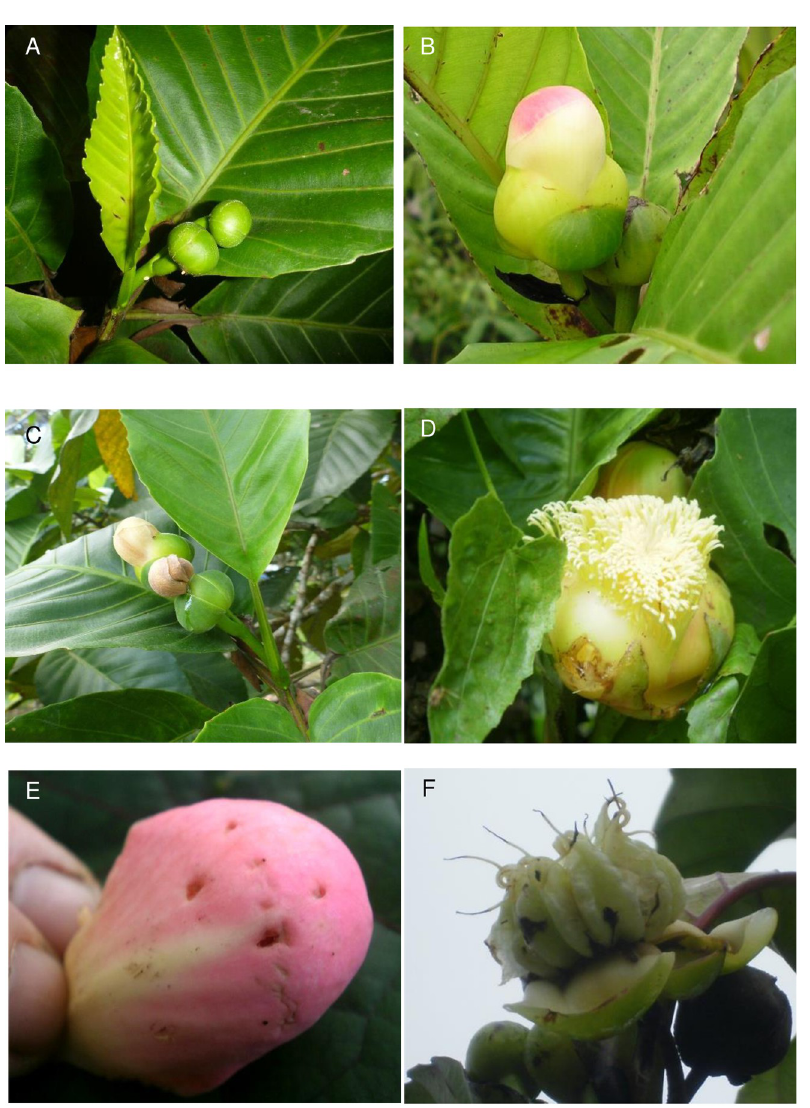
Fig 2. Reproductive development in Dillenia biflora . (A) Pair of buds in terminal leaf whorl. (B) Globose corolla on virgin flower (creamy white to light pink). (C) Failed flowers from no bat visit; sepals closed trapping corolla. (D) Open multi-staminate flower, corolla removed by bats. (E) Detached corolla with bat bites. (F) Mature open